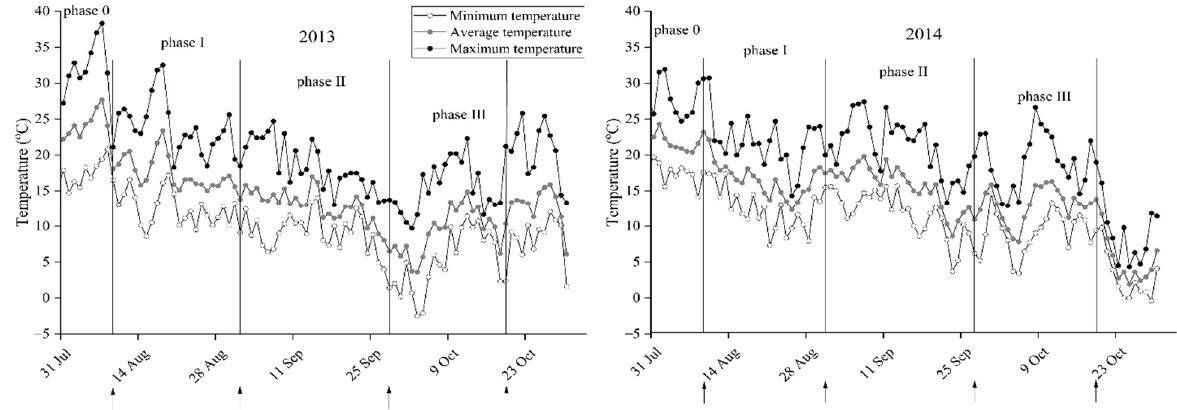
Figure 2. Temperature conditions during the 2013 and 2014 sampling periods. The lines correspond to the minimum, average and maximum temperatures (°C). The arrows indicate the sampling dates. The sampling period phases are indicated (phases 0–III).